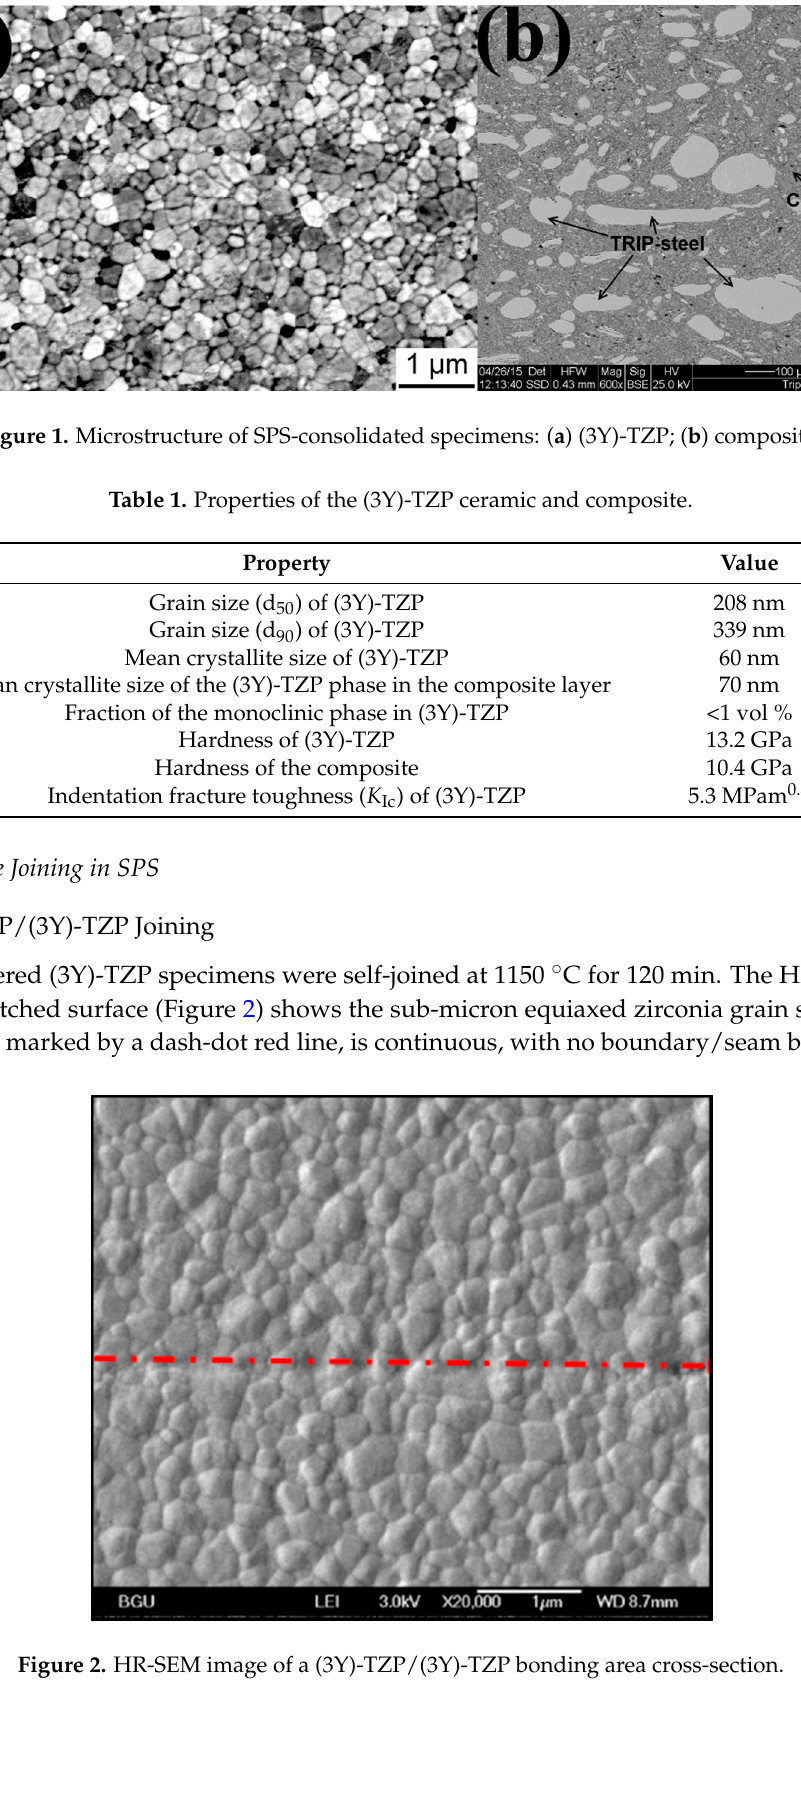
Table 1. Properties of the (3Y)-TZP ceramic and composite.